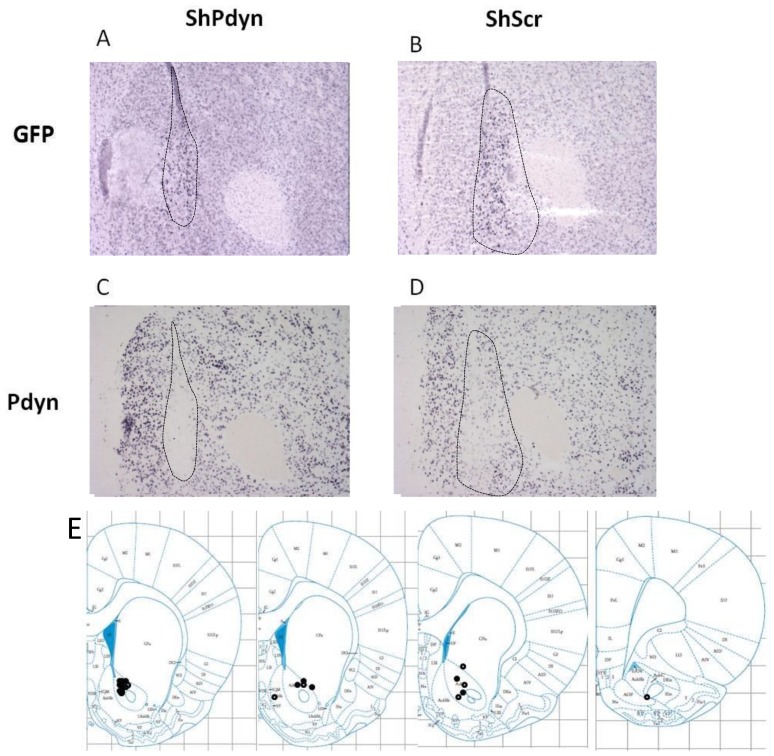

In situ hybridization results.
In situ hybridization with a GFP probe was conducted to assess location and extent of viral transduction in rats administered with a rAAV viral vector expressing a shRNA sequence directed at Pdyn transcript(shPdyn) or a control scramble sequence (shScr) into their nucleus accumbens (NAcc). Figures A (shPdyn rat) and B (shScr rat) portray the typical limited transduction volume within the NAcc observed in all subjects. In situ hybridization with a Pdyn probe demonstrated substantial reduction of Pdyn mRNA expression in the transduced region of the shPdyn rats (C) compared to the shScr rats (D). The locations of the rAAV injection sites in each rat are depicted in panel E. Solid black circles: shPdyn rats; white circles: shScr rats.